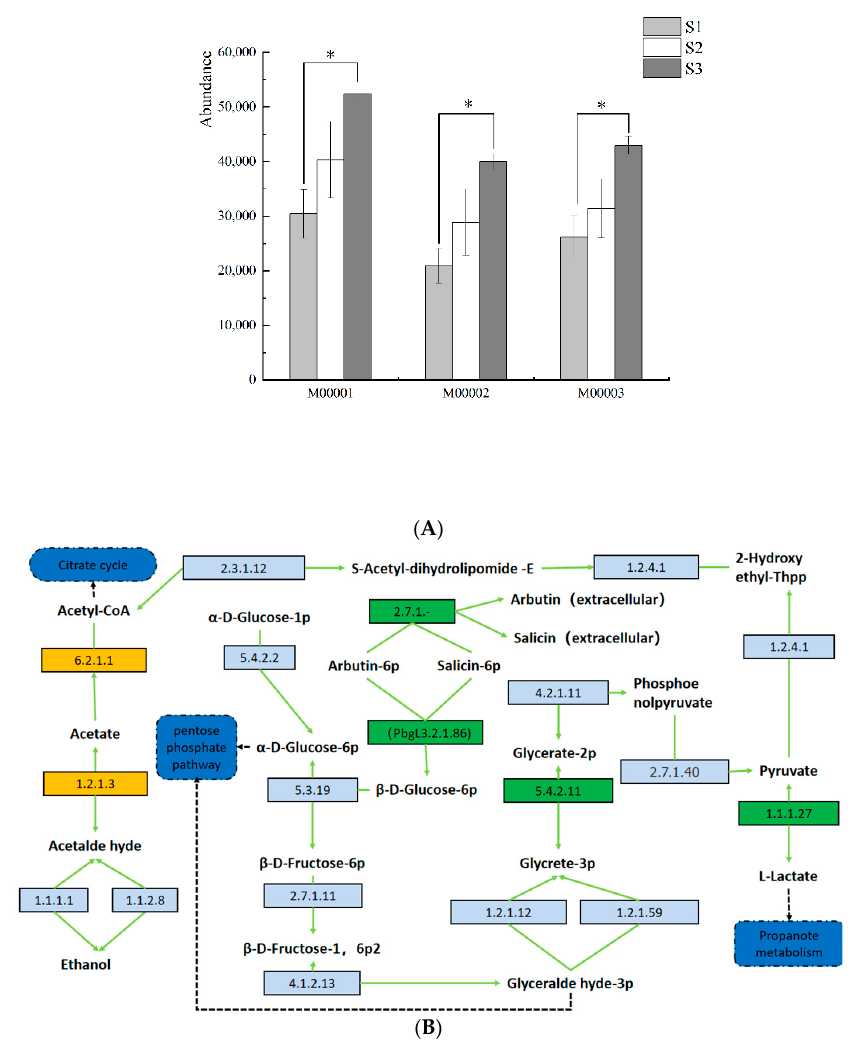
Figure 8. Comparison of glycolysis metabolism at different stages of paocai fermentation ( A ) and metabolic pathway diagram ( B ); (where M0001 is Glycolysis (Embden-Meyerhof Pathway), glucose => Pyruvate, M0002 is Glycolysis, Core Module involving three − Carbon Compound, M0003Gluconeogenesis, Oxaloacetate => Fructose 6P. Green indicates that the enzyme abundance in S3 stage is higher than that in S1 stage, and yellow indicates that the enzyme abundance in the S1 stage is higher than that in S3 stage, * p < 0.05).